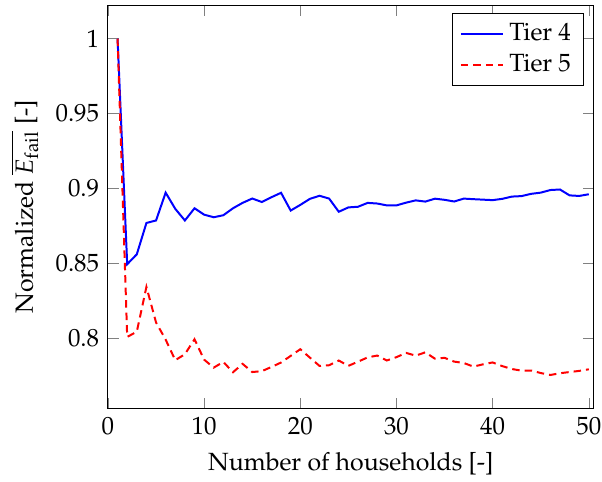
Figure 13. Variations in normalized average E fail per household for homogeneous microgrids composed of tiers 4 and